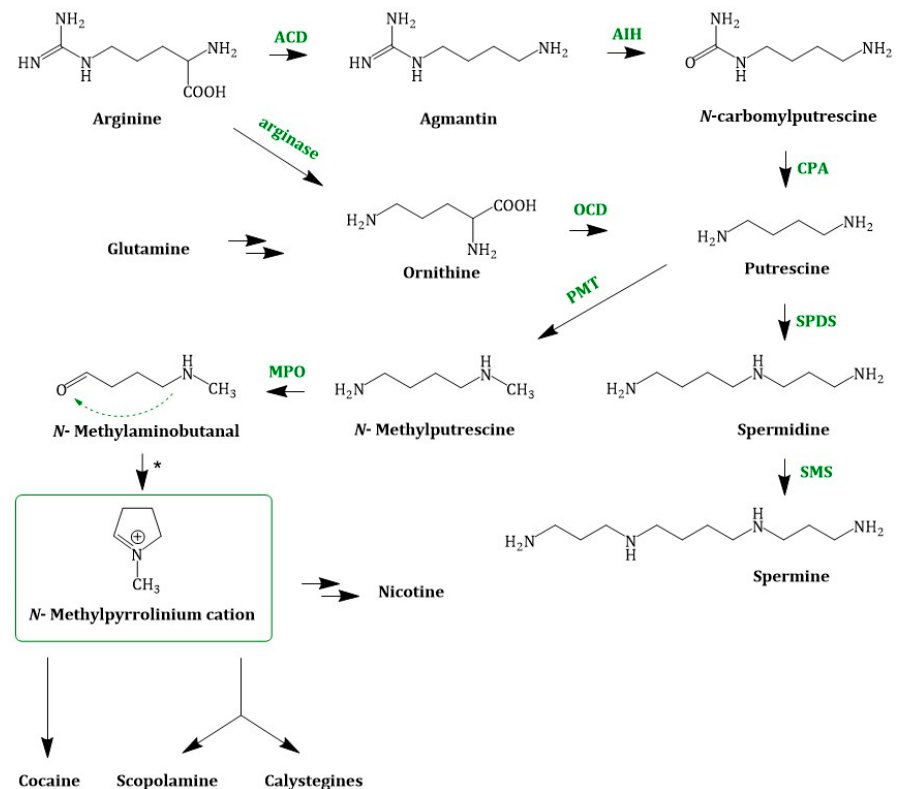
Figure 3. Joint steps of the early TA biosynthesis; ACD = arginine decarboxylase; AIH = agmatine Figure